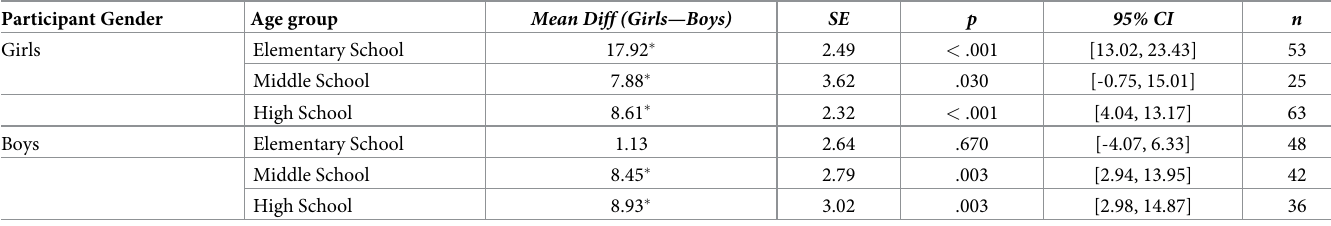
Table 6. Pairwise comparisons of explicit scores by age group and participant gender.